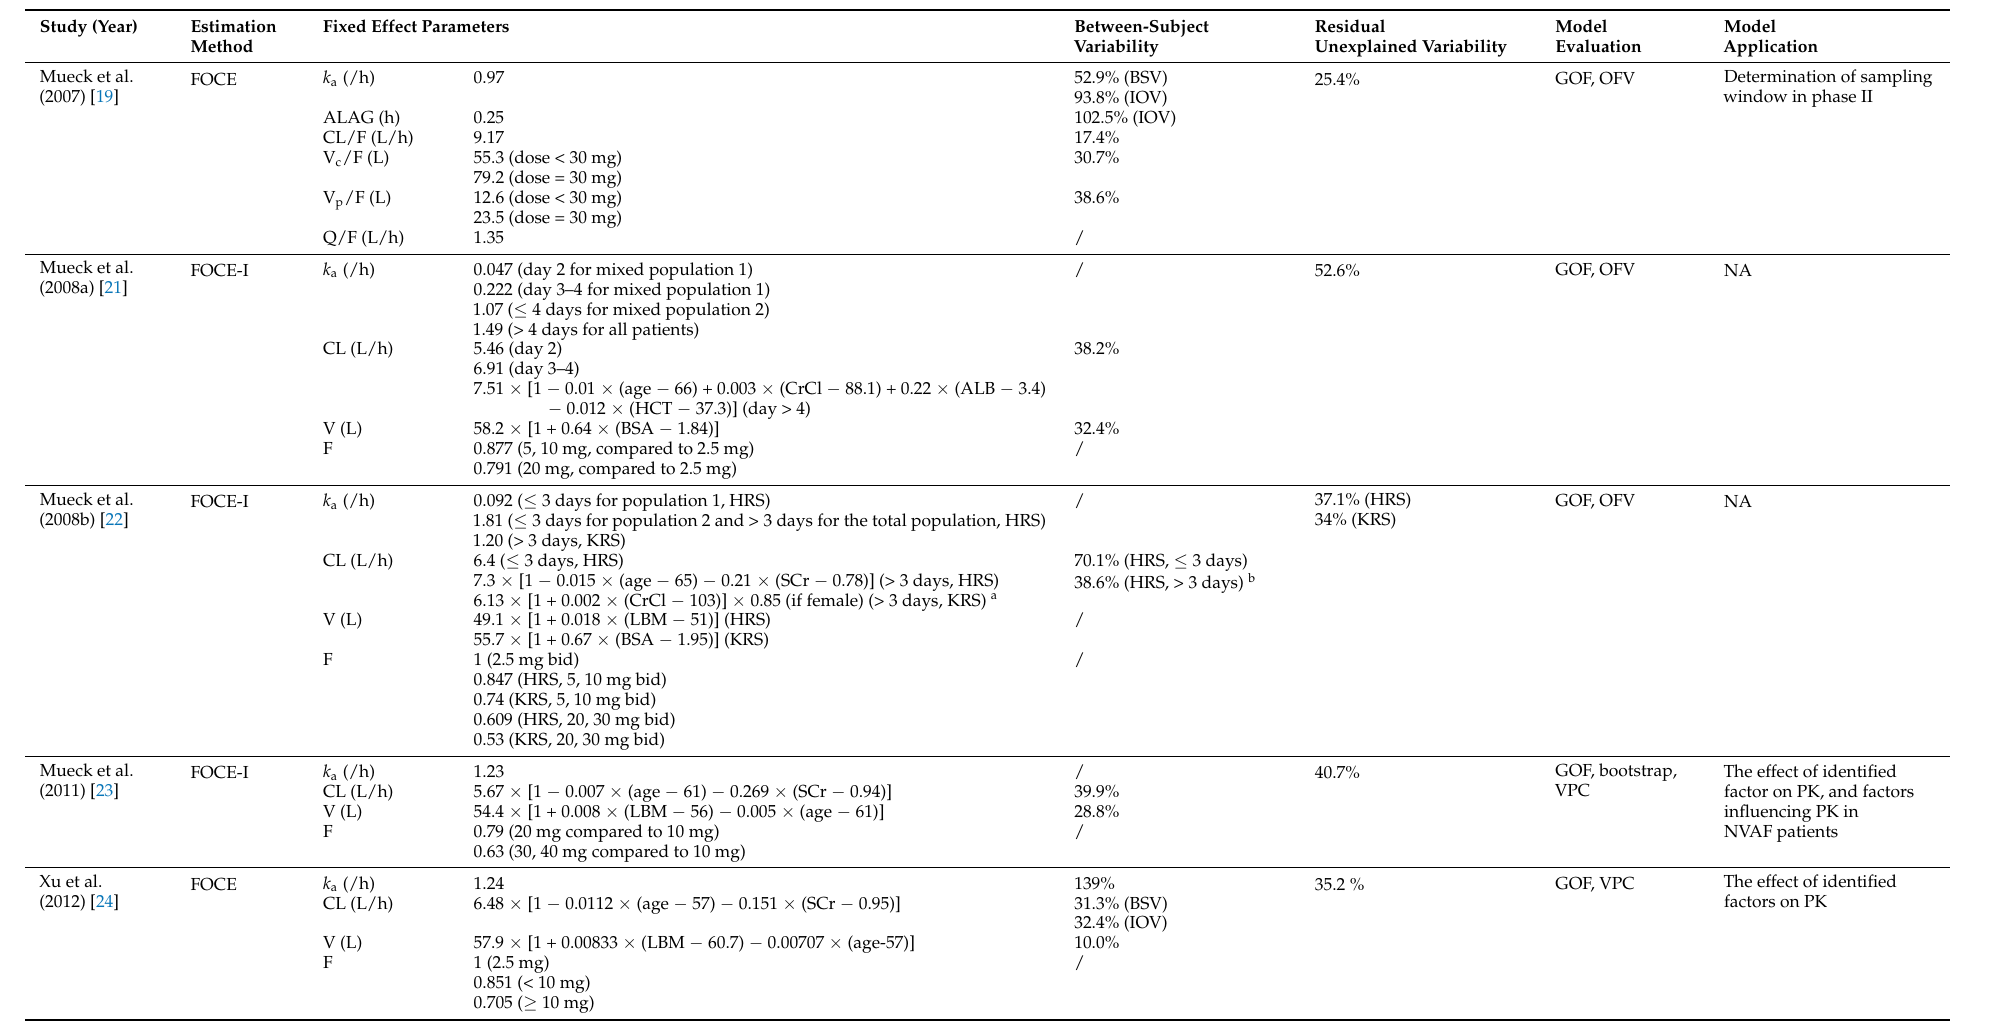
Table 2. Final population pharmacokinetic parameters of included